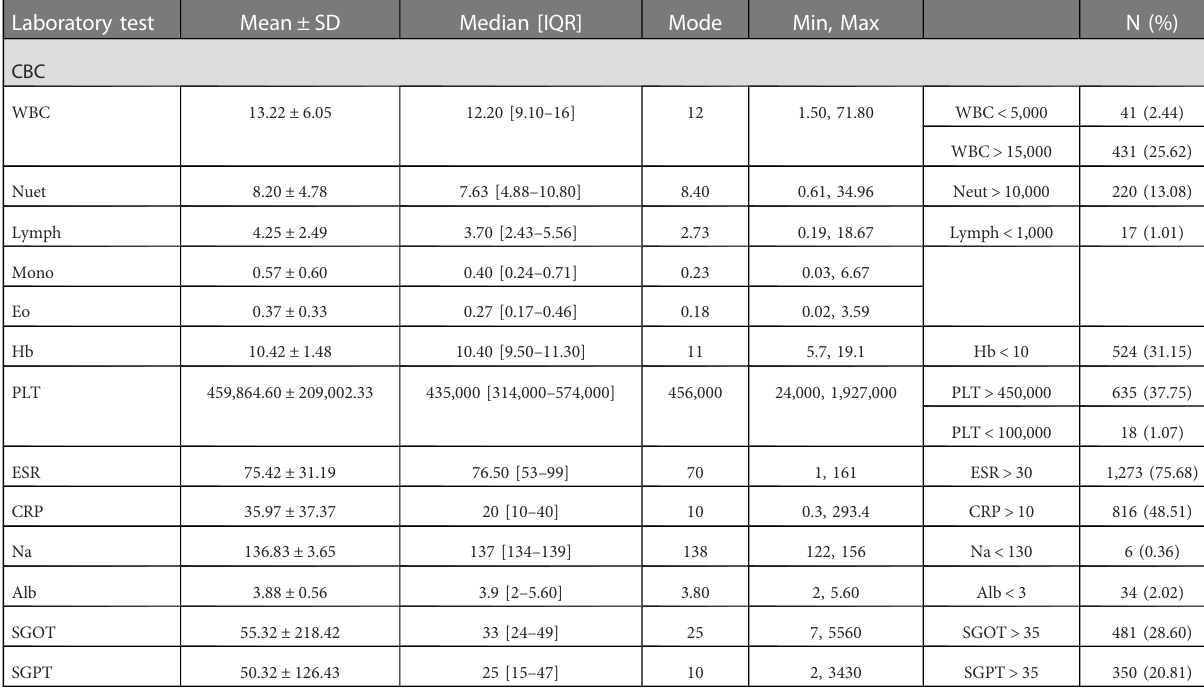
TABLE 3 Laboratory characteristics of the patients with the diagnosis of KD ( N =1682). Laboratory